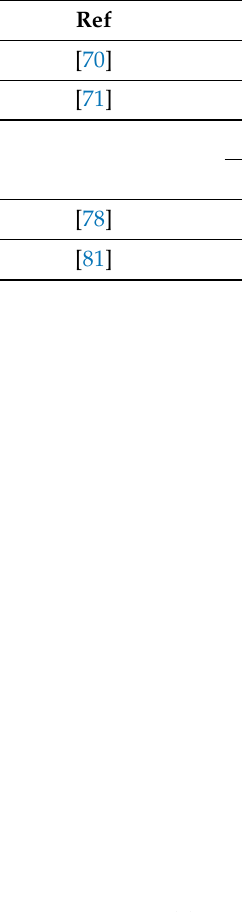
Table 28. Comparison of the Results on the Oxford Robot-car, MVSEC, and In-House Datasets. Oxford